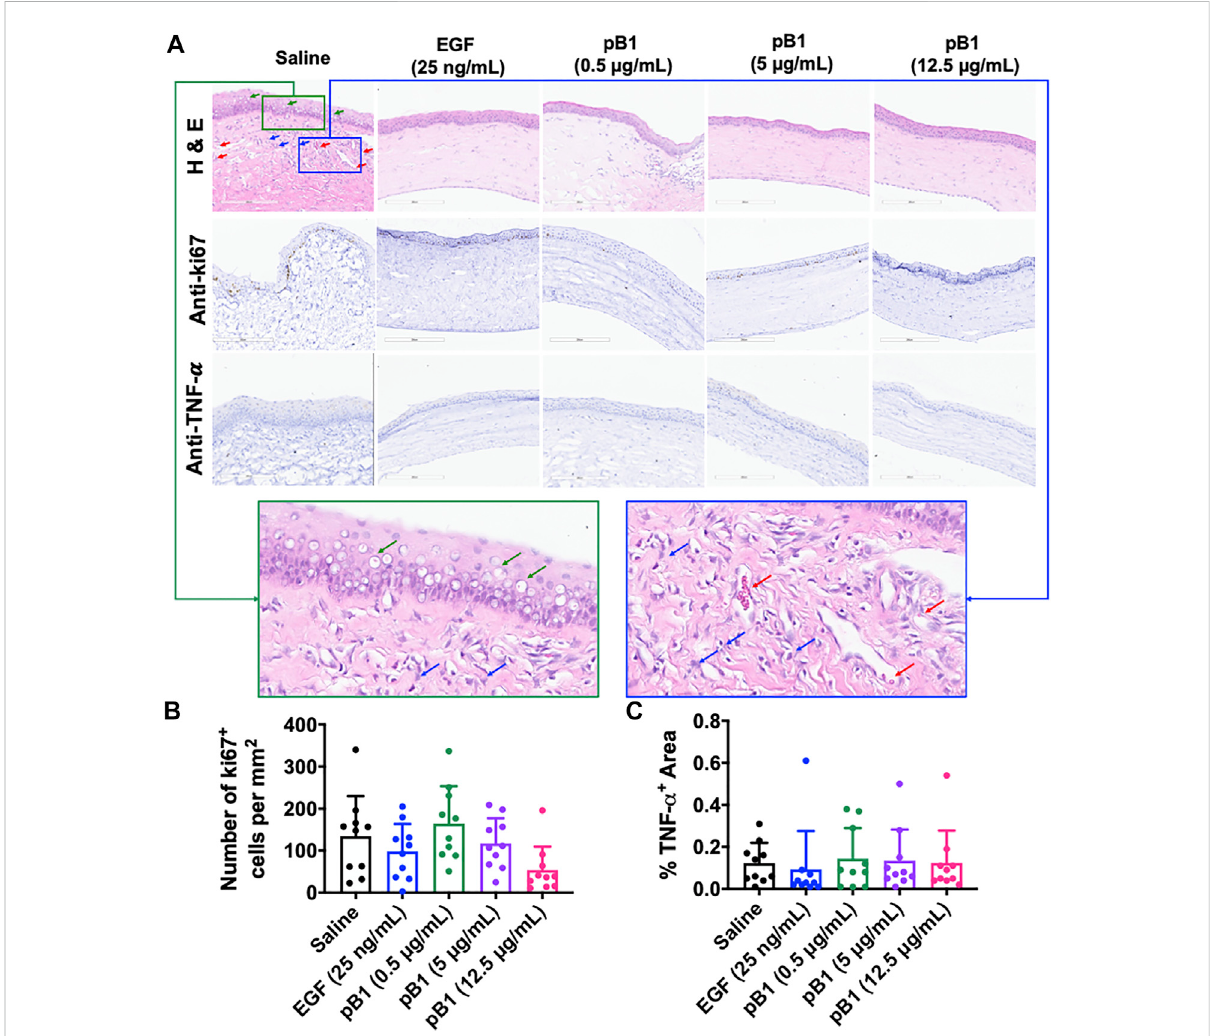
FIGURE 5 (A) Cross-sectionsofcorneasharvested14 daysaftertheinjurywerestainedwithhematoxylinandeosin(inordertovisualizethecornealtissue structure and the in fi ltration of in fl ammatory cells), and were immunostained for the proliferative marker Ki67 and the in fl ammatory marker tumor necrosis factor alpha (TNF- α ). Green boxed area represents the magni fi ed area with high level of corneal vacuole formation and in fl ammatory cell in fi ltration.Blueboxedarearepresentsthemagni fi edareawithhighlevelofin fl ammatorycellin fi ltrationandbloodvesselformation.Redarrow: bloodvessels.Bluearrows:neutrophils.Green arrows:corneal vacuoles (B,C) Barchartsdemonstrating (B) thenumber ofKi67-positiveproliferating cells and (C) theTNF- α -positive areas ofall corneal injurygroups. Fivecorneal injury groups:(1) saline control (10rats),(2) EGF (25 ng/ml; 10 rats), (3) pB1 (0.5 μ g/ml; 10 rats), (4) pB1 (5 μ g/ml; 10 rats), and (5) pB1 (12.5 μ g/ml; 10 rats). All results are expressed as the mean ± standard deviation (SD); *: p < 0.05 for all treated groups, as compared with the saline control group. Notes: EGF: epidermal growth